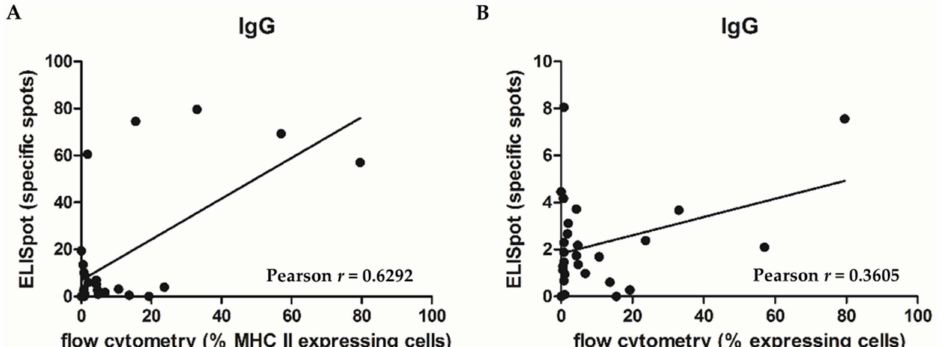
Figure 3. Correlation of Ig secretion with cellular tumor composition. ( A ) Correlation of IgG secretion and MHC II expression of CRC samples. The plot depicts the correlation between IgG secretion (on the Y -axis, assessed by FluoroSpot analyses) and MHC II expression (on the X -axis, assessed by flow cytometry) of CRC tumor cells. ( B ) Correlation of IgG secretion and B cell levels of CRC samples. The plot depicts the correlation between IgG secretion (on the Y -axis, assessed by FluoroSpot analyses) and B cell quantity (on the X -axis, assessed by flow cytometry using the lineage panel CD19 / 20 / 21) of CRC tumor cell